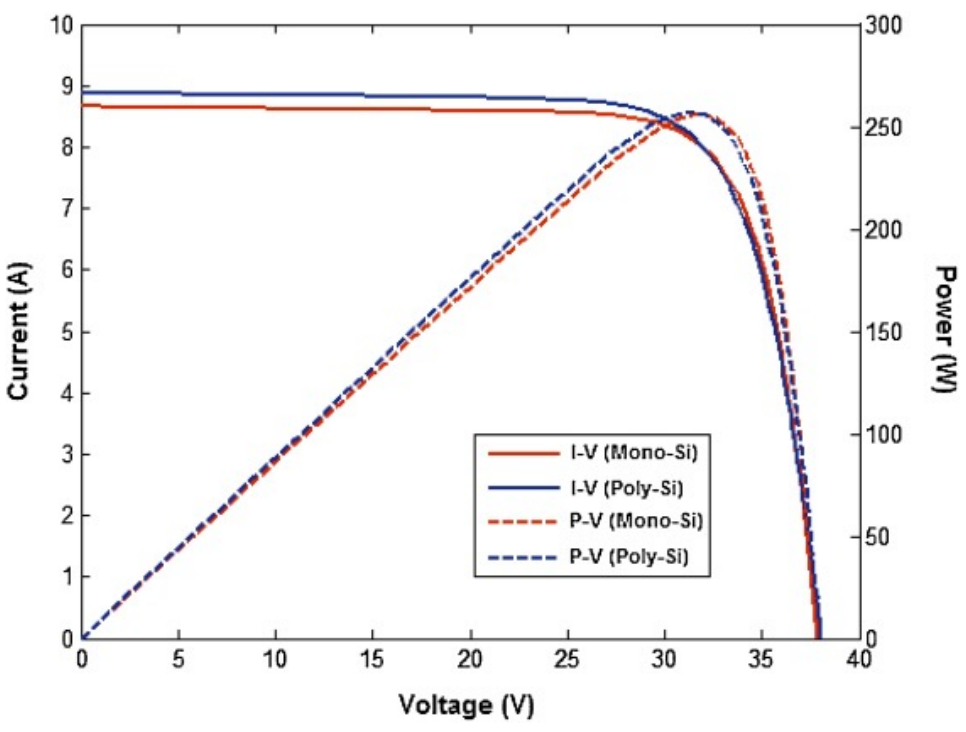
Figure 7. Comparison between Poly-Si and Mono-Si characteristic curves [68].